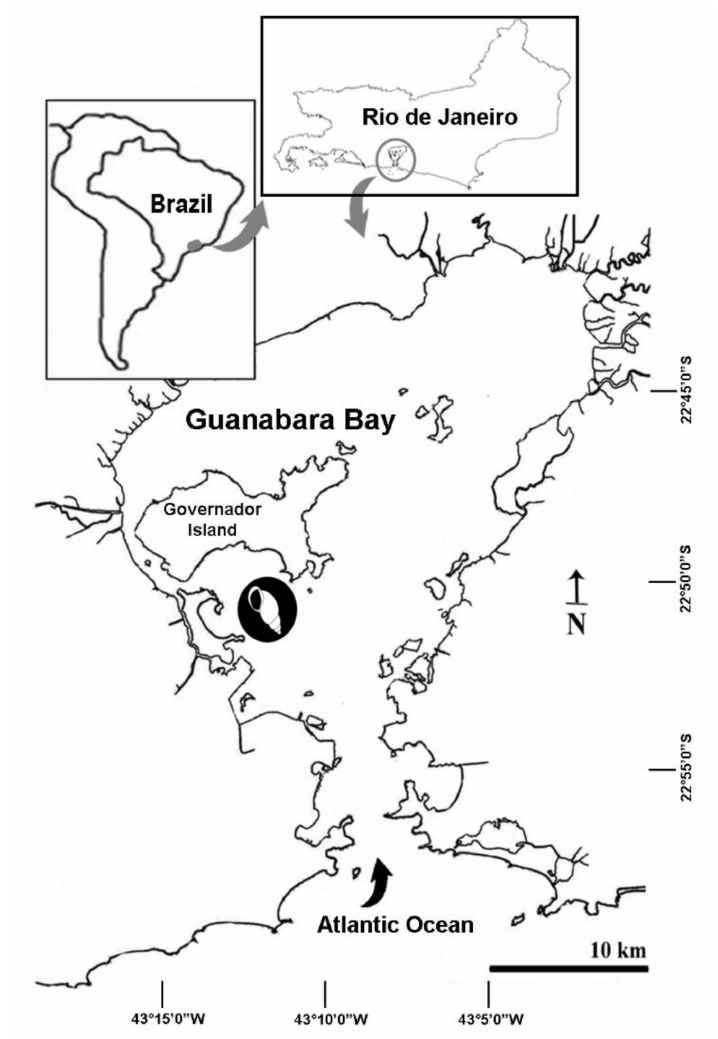
Figure 1. Geographic location of Guanabara Bay (Rio de Janeiro, Brazil), showing the sampling region (i.e., black ellipse with a snail